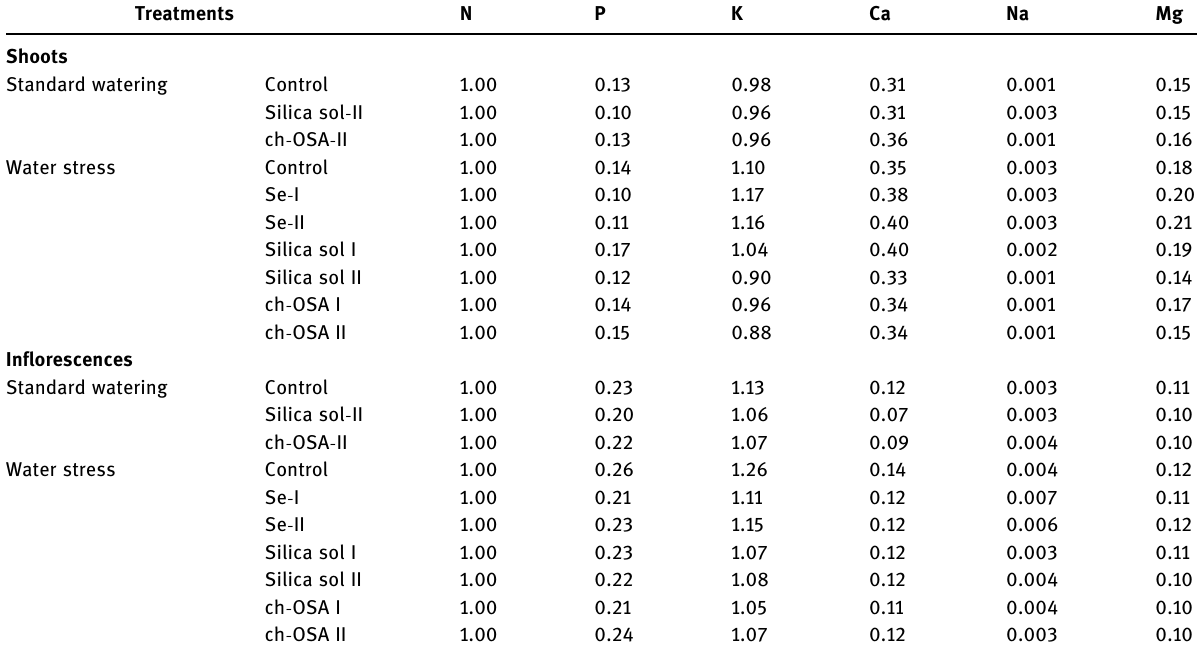
Table 5: The quantitative relations between macroelements and sodium in shoots and in fl orescences of Tagetes patula L. “ Pascal. ” For each combination the N content was taken as 1.00 Treatments Shoots Standard watering